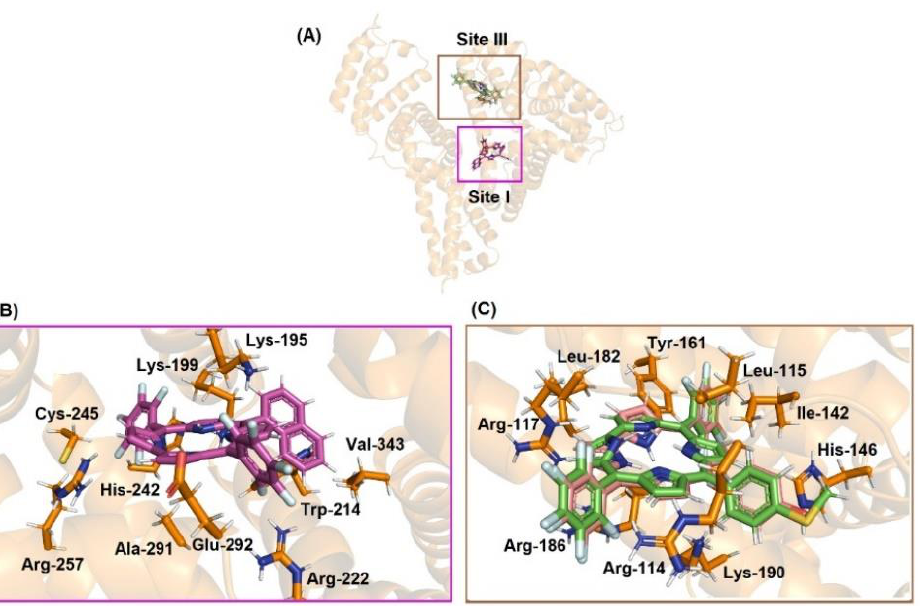
Figure 9. ( A ) Superposition of the best docking pose for HSA:corroles in the Sites I and III. Best docking pose for ( B ) HSA: 2 into site I and ( C ) HSA: 3/4 into site III. Selected amino acid residue and corroles are in stick representation in orange, pink, beige, green, and brown, respectively. Elements’ color: hydrogen: white; oxygen: red; nitrogen: dark blue, fluorine: light blue, and sulfur: yellow.